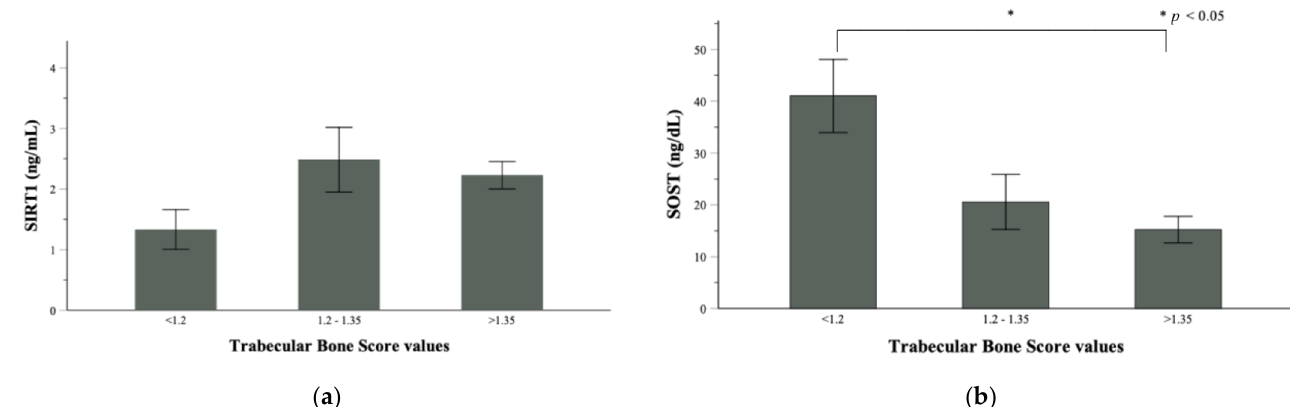
Figure 2. Distribution of ( a ) plasmatic SIRT1 and ( b ) sclerostin according to TBS categories. TBS < 1.2 indicates bone microarchitecture degradation, TBS between 1.2 and 1.35 indicates a partially degraded microarchitecture and TBS > 1.35 represents a normal microarchitecture.